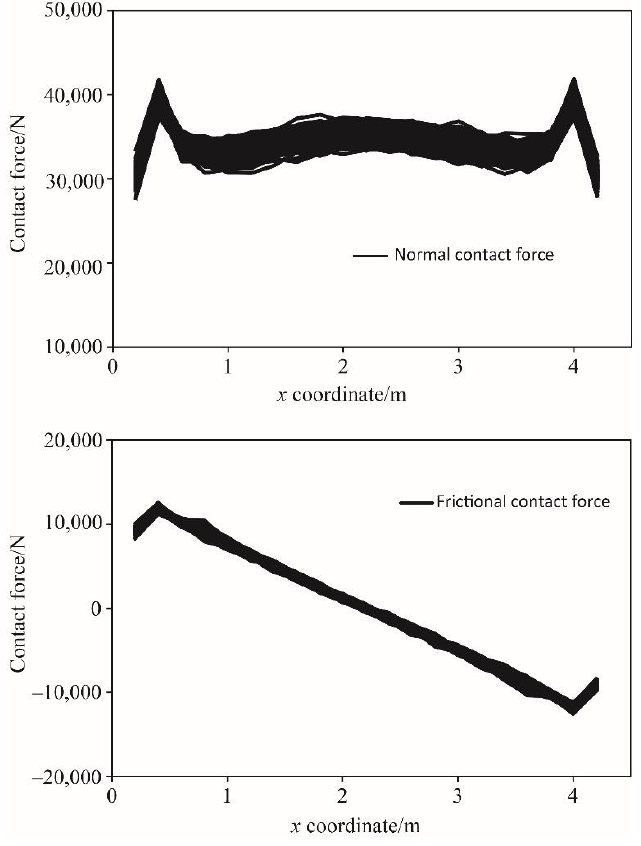
Figure 8. Contact force from 500 realisations when the coefficient of friction is 0.3.